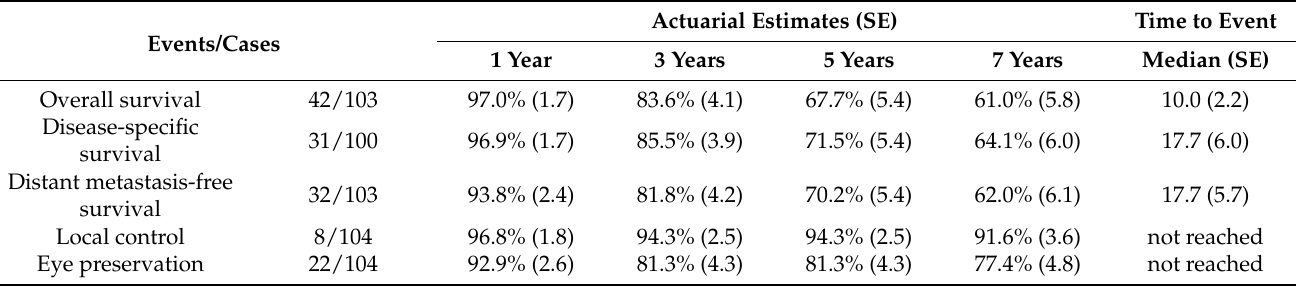
Table 2. Survival, local tumour control and eye preservation after proton therapy for uveal